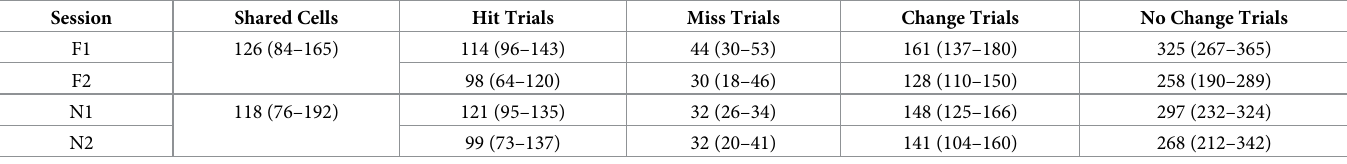
Table 2. Shared cell and engaged trial count for behavioral